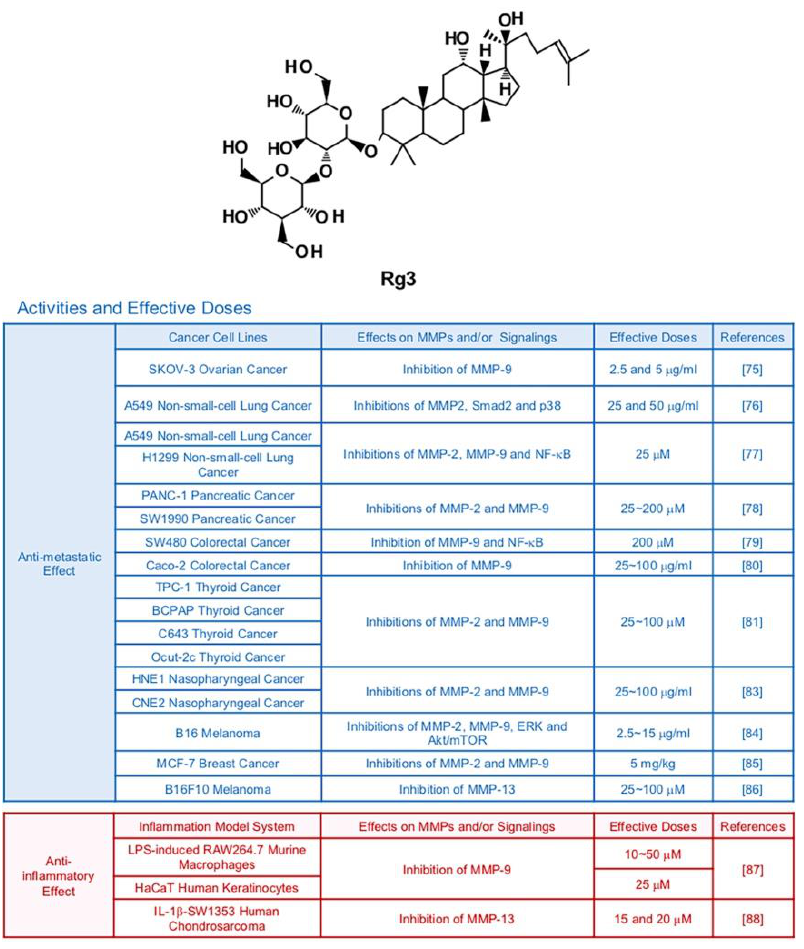
Figure 4. Summary of activities of ginsenoside Rg3. Structure of Rg3 and its effects on MMPs and/or signalings [75–81,83–88].